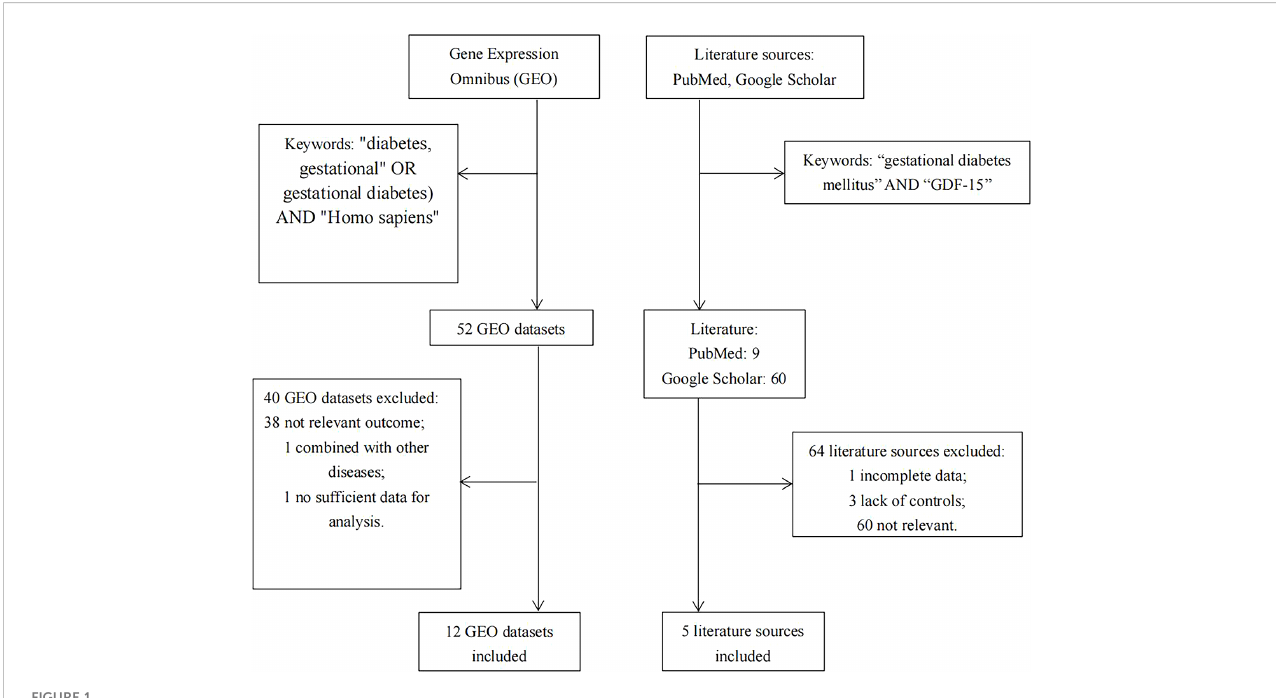
FIGURE 1 Flow diagram for literature